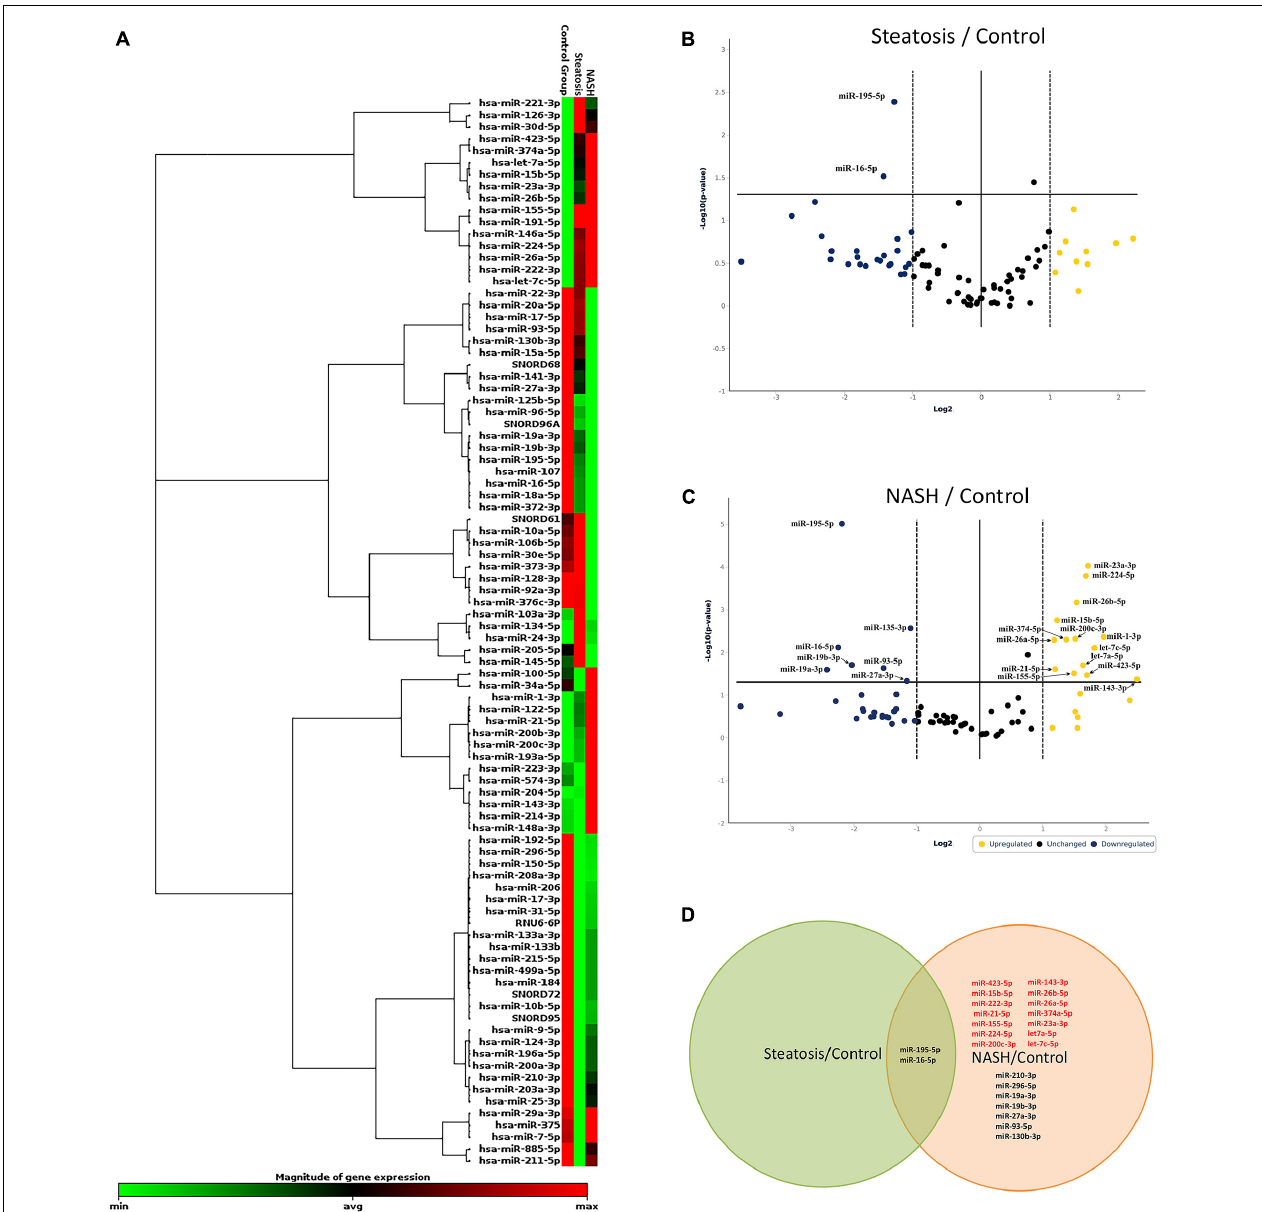
FIGURE 3 | Identification of differentially expressed miRNAs. (A) Hierarchical cluster analysis. Red—increased miRNA; green—decreased miRNA; black—no changes in expression. The magnitude of gene expression is determined by calculating the 2- (cid:49) CT for each gene and normalizing to the average 2- (cid:49) CT of all genes across all arrays. Volcano plot of differentially expressed miRNAs in serum; (B) group of patients with steatosis and (C) group of patients with NASH. Plots show the relationship between fold change and statistical significance. The solid vertical line shows no change in gene expression (log 2 1 = 0). Data points to the right of the solid vertical line indicate activated genes, and data points to the left indicate repressed genes. The dashed lines represent the threshold—2. The solid vertical line represents the threshold of statistical significance, p < 0.05. Thus, the blue and yellow dots in the graph indicate > 2.0-fold activation and suppression of expression with statistical significance. (D) Venn plot of miRNA profile overlap showing common and unique miRNAs in serum from groups of patients with steatosis and NASH. Expression activation is highlighted in red, while statistically significant expression suppression is highlighted in black (D)